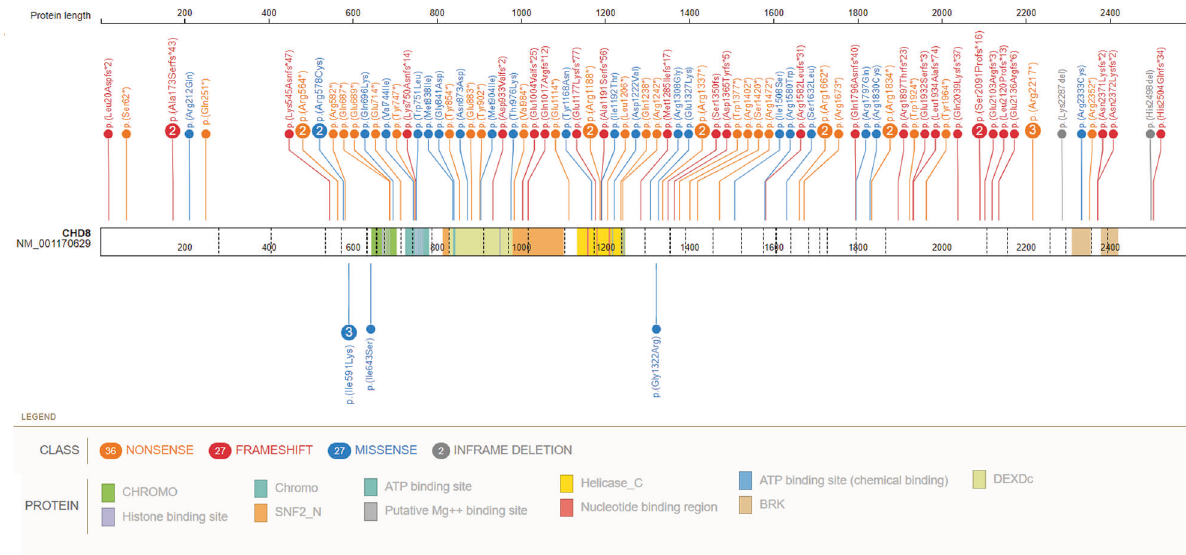
Fig. 3 Variants found in CHD8 . The splice site variants, exon deletion and translocation are not shown. Above: all (likely) pathogenic nonsense-, frameshift- and missense variants, with the two inframe deletions added as well. The missense variants are rather spread out over the gene and there does not seem to be a clear relation with a speci fi c domain or protein function, as sometimes is the case (and could help with assessing pathogenicity). Below are the fi ve variants of which pathogenicity is unknown, including the two with a different methylation signature. Dashed lines indicate the different exons.